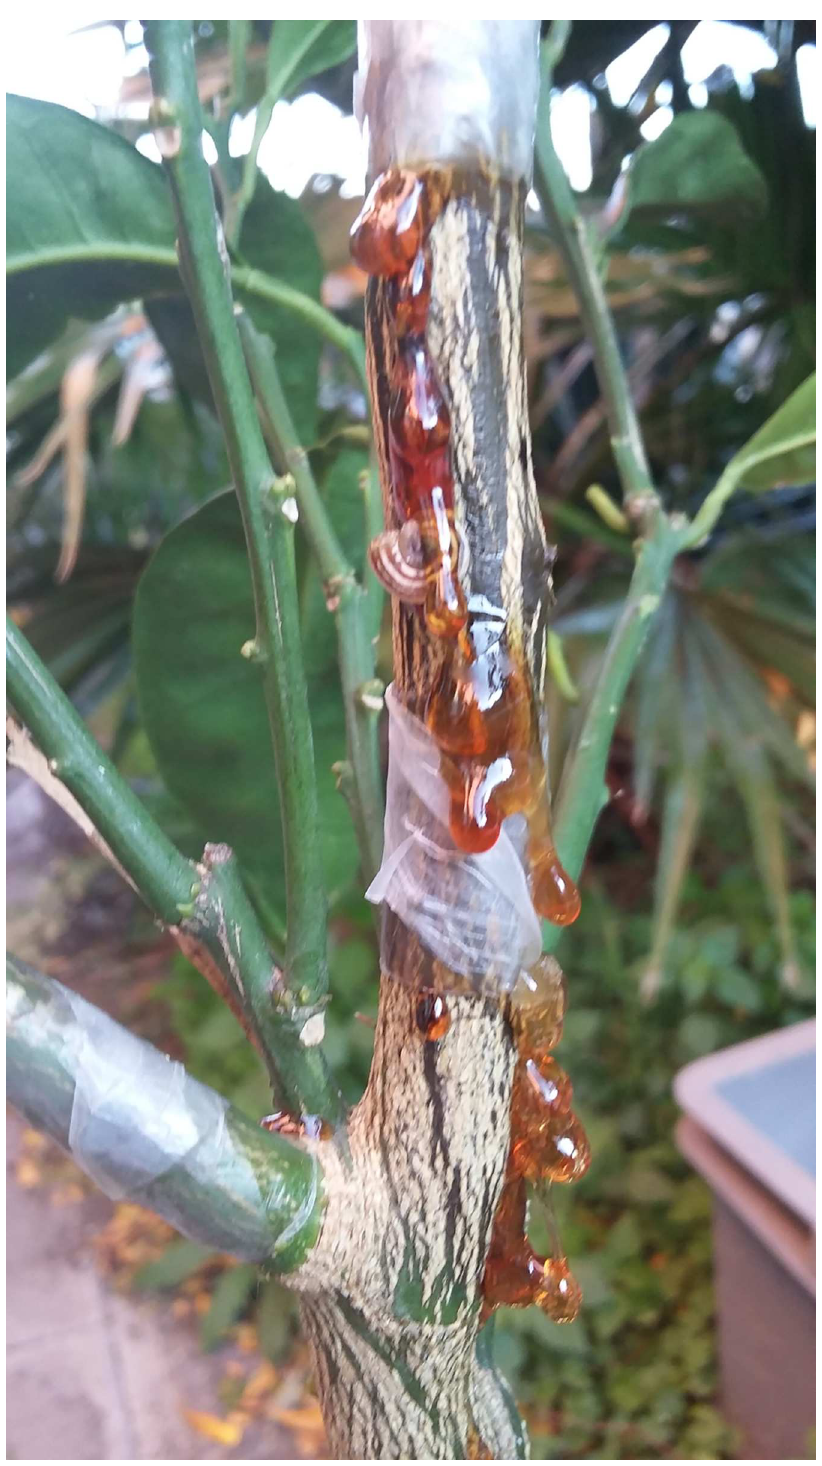
Fig 7. Gum exudate oozing from the twig of a sweet orange ‘Lane Late’ wound inoculated with isolate PF6f2 of P . sp. mekongensis from Vietnam, 12 days after